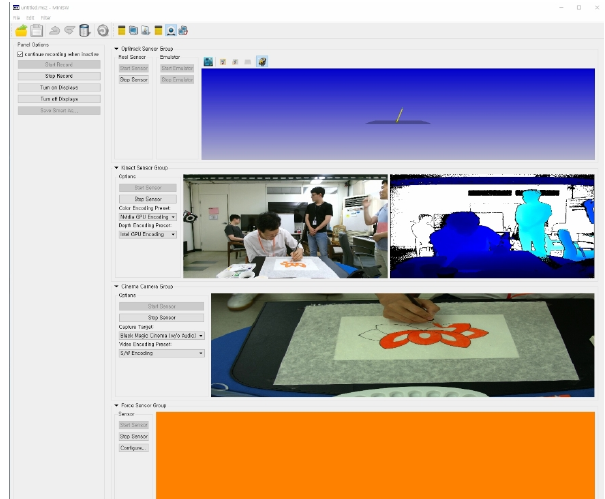
Figure 4. The program screen during the capture. The views show brush poses, color, and depth images from the Kinect; canvas images; and pigment information,